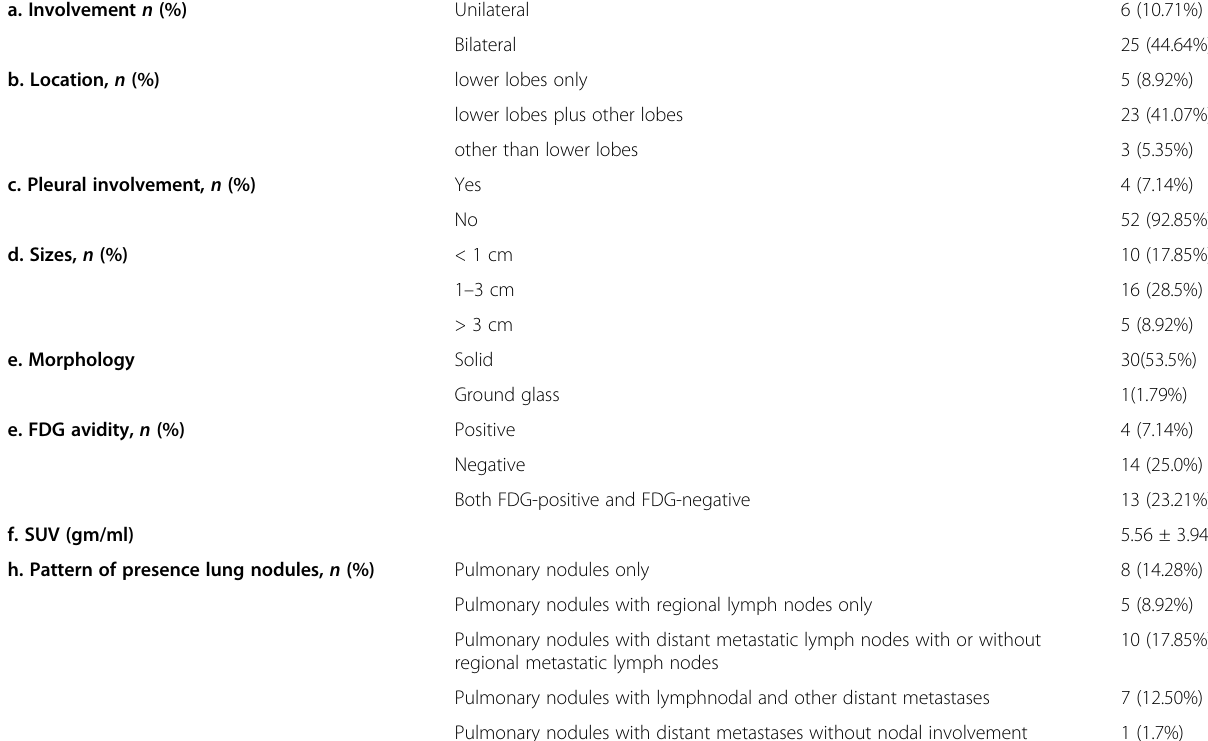
Table 7 Patterns of pulmonary metastases on FDG PET CT, n = 56